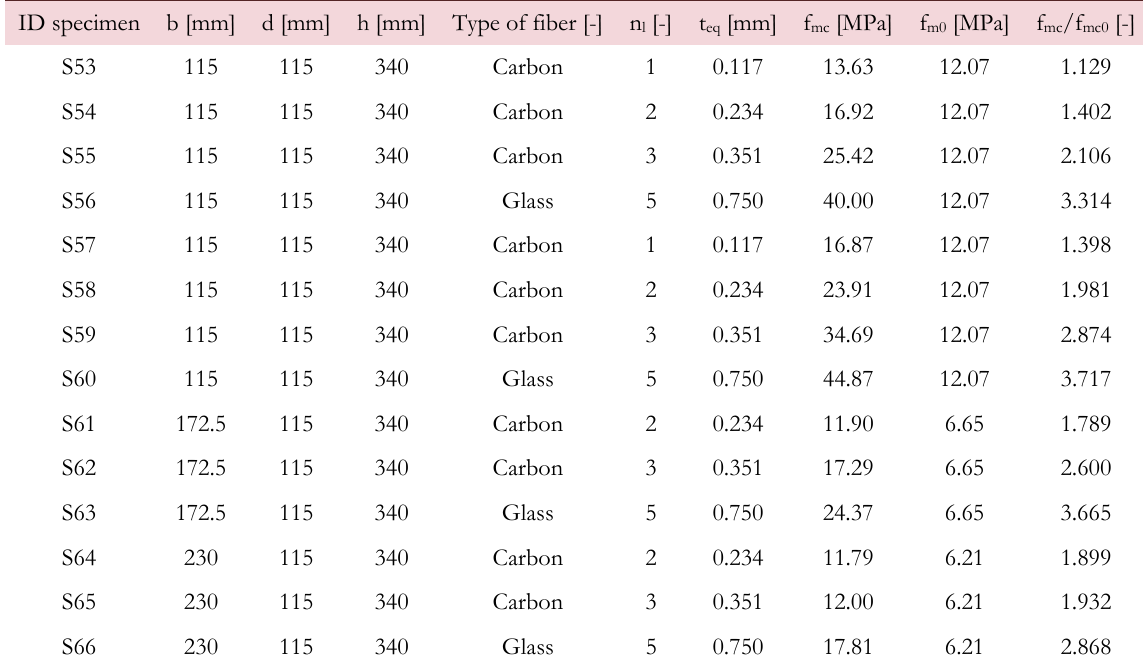
Table 13.B: Geometrical characteristics and experimental results [39].